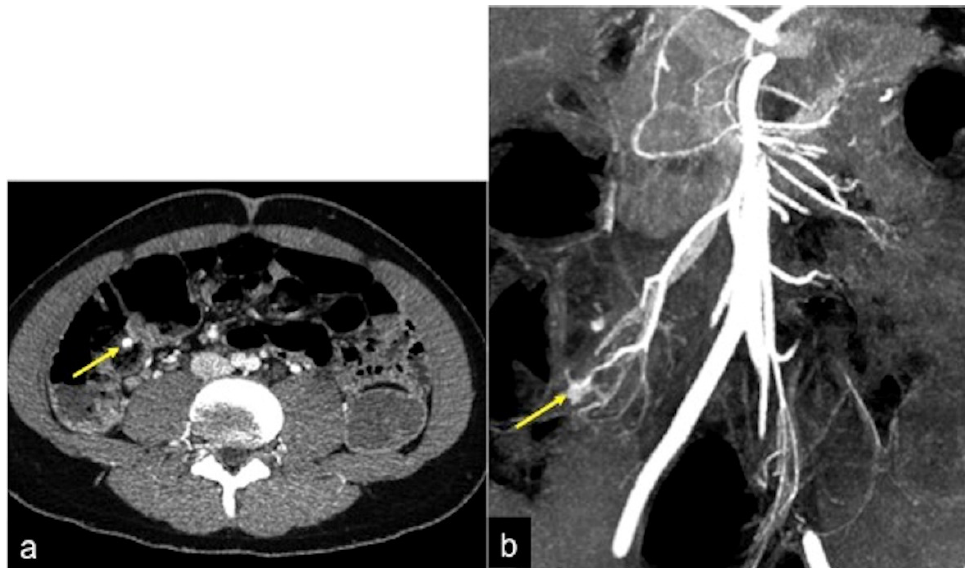
Figure 5. CTA study of a haemorrhagic spot in the ascendant colon. A vascular nidus (arrow) is detected in the arterial phase ( a ); the MIP post-processing with MPR coronal reconstruction facilitates the identification of the vascular malformation (arrow) in order to better define the vascular anatomy for the treatment approach ( b ).